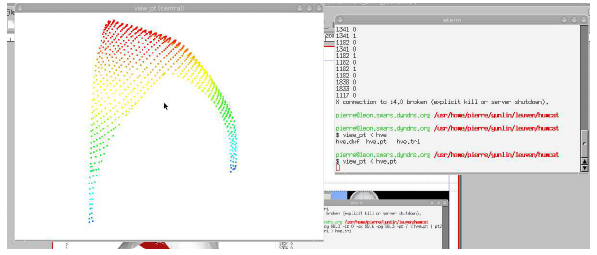
Figure 3: Real-time control of the total station